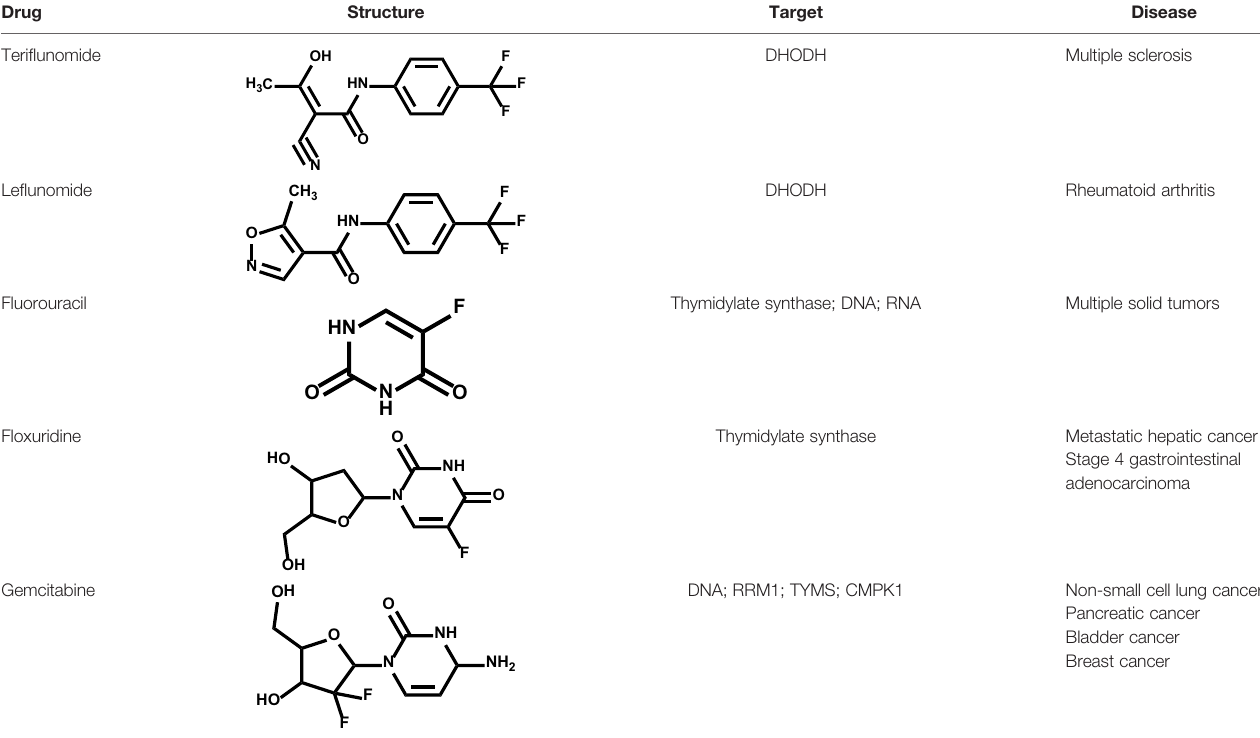
TABLE 1 | Small molecular inhibitors of pyrimidine metabolic pathway approved by FDA. Drug Structure Target